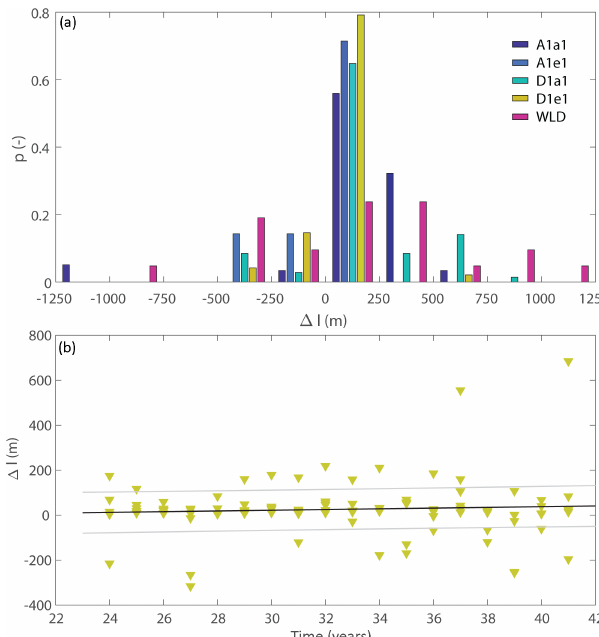
Figure 6. (a) Histogram of (cid:49)l for numerical models A1a1 (dark blue), A1e1 (light blue), D1a1 (seafoam), and D1e1 (yellow) com- pared with measurements from the Wax Lake Delta (pink). All his- tograms are binned at 250m intervals. Descriptive statistics of these populations are shown in Table 1. (b) The location of (cid:49)l as a func- tion of time (model years) for delta run D1e1. A linear fit (black line) with 50% confidence interval (gray lines) is shown. The trend of this fit is not statistically significant and is small compared to variation within (cid:49)l